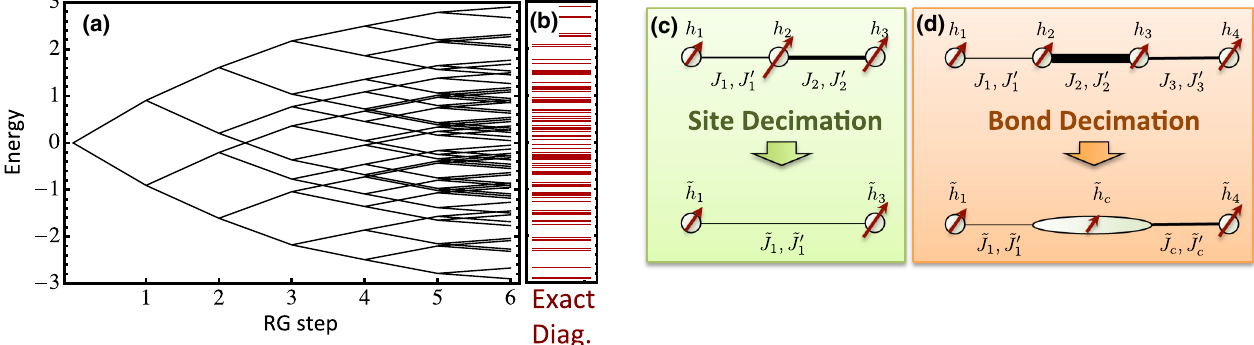
FIG. 2. (a) The RSRG-X tree for a six-site Ising chain. The leaves of the tree correspond to the many-body eigenstates of the spin chain. (b) The corresponding eigenspectrum found by exact diagonalization. (c),(d) RSRG-X rules for site (c) and bond (d) decimation in the hJJ 0 model. In the site decimation rule, a local magnetic field ( h 2 ) is the dominant coupling; thus, the corresponding local spin is either aligned (ground state) or antialigned (excited state) with it. Eliminating h 2 , we obtain a new set of couplings second order (see Appendix B for details). In the bond decimation rule, J 2 is the dominant coupling, corresponding to the neighboring spins being either aligned (ground state) or antialigned (excited state, i.e., a domain wall) along the x